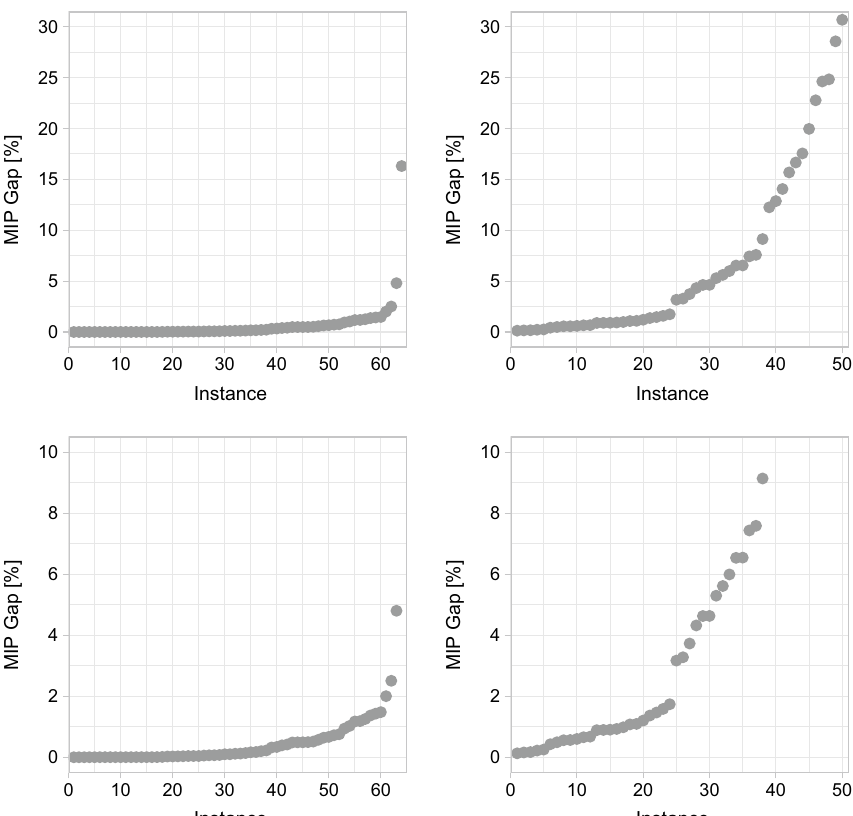
Fig. 3 MIP gaps sorted in ascending order for medium ( on the left ) and large instances ( on the right ). Depicted are 64 medium and 50 large instances, including those solved to optimality. The upper figures show the gaps for all instances, the lower figures are zoomed in for better